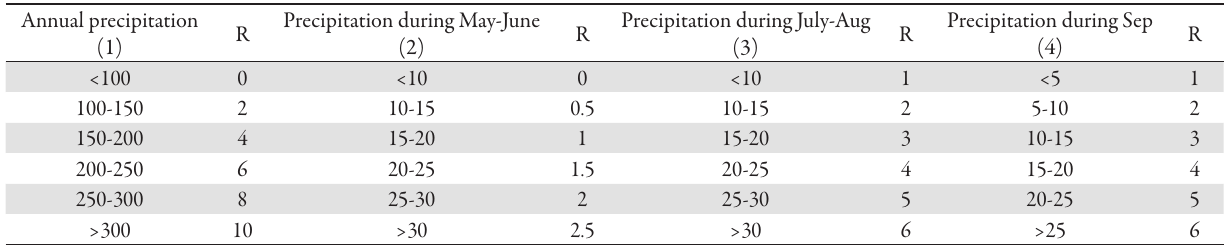
Tab. 7. Rating values for precipitation